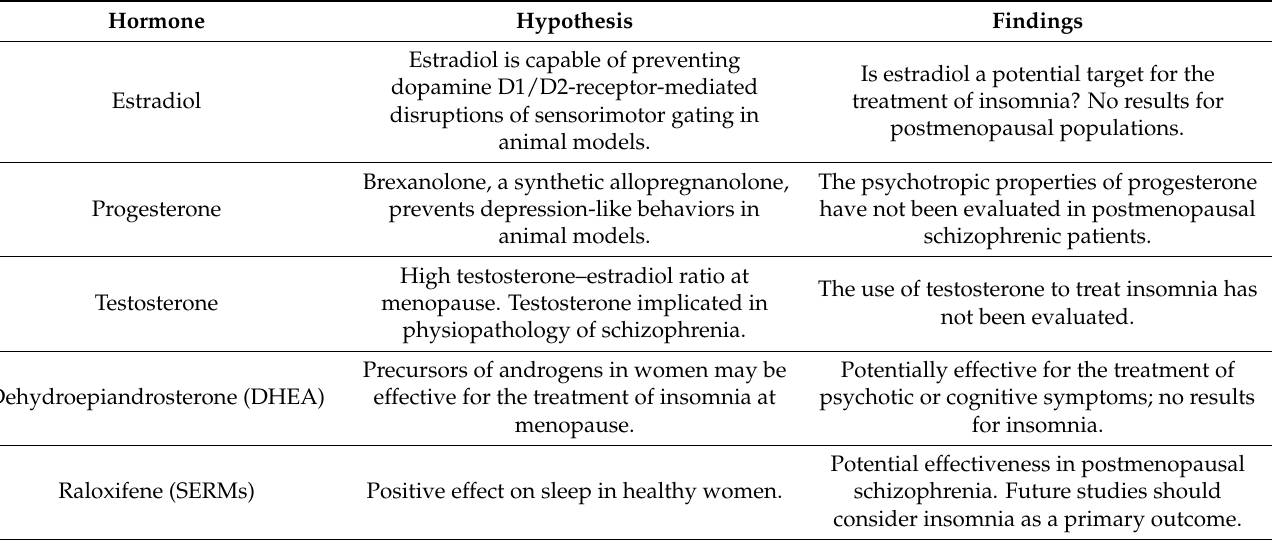
Table 3. Effects of sex hormones and raloxifene for the treatment of insomnia in postmenopausal schizophrenic